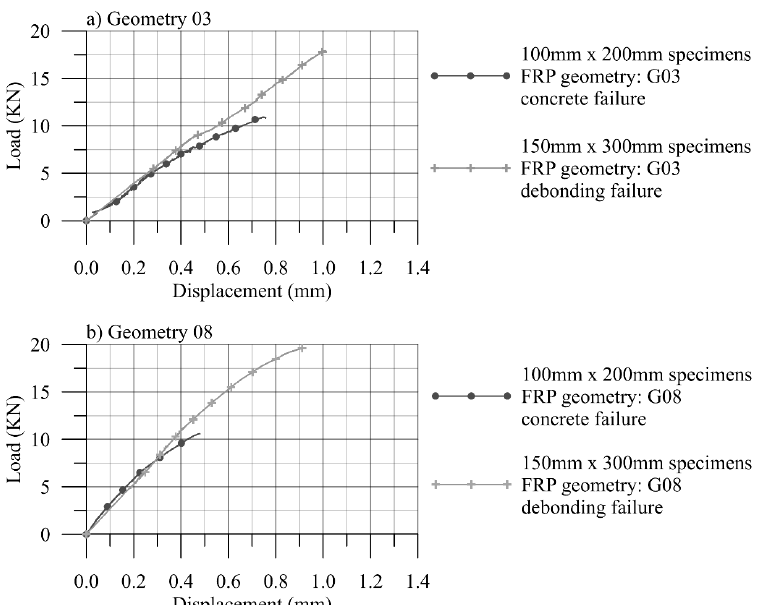
Figure 11. Plot of load versus displacement to the peak in experiments with the same FRP geometry and different failure modes.